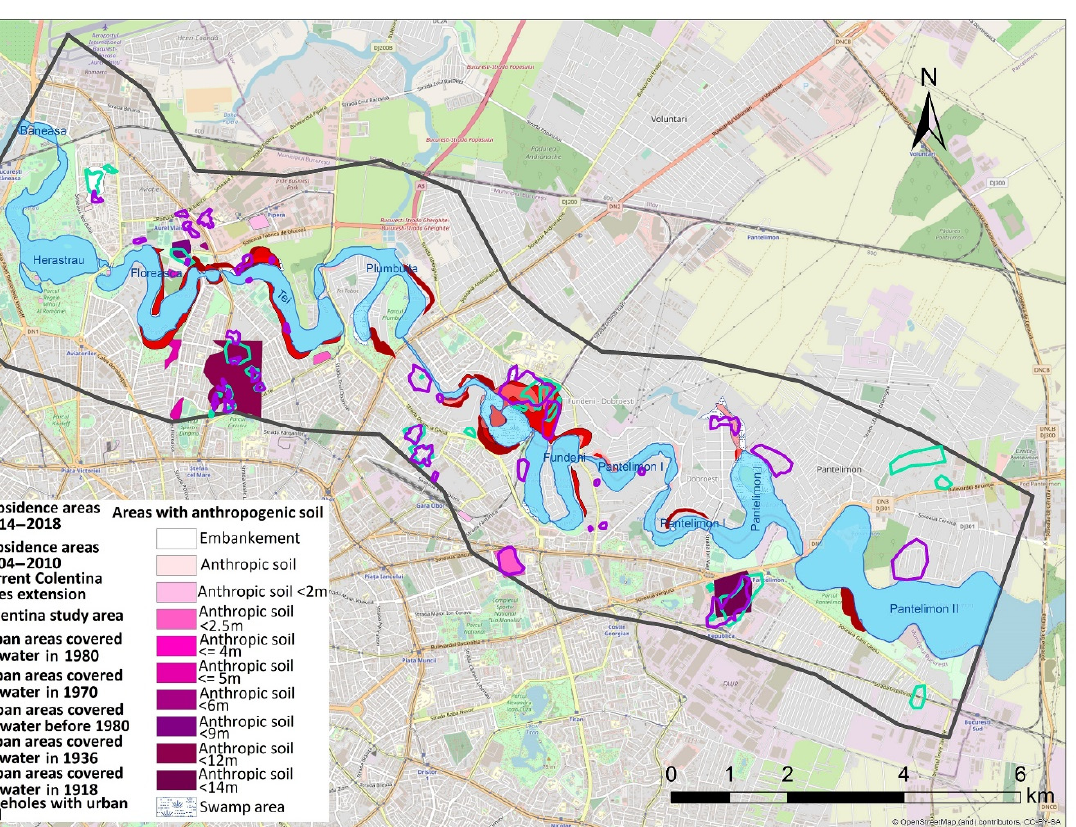
Table 4. Processed information for Promenada, Pod BV, Gara Herastrau, and Soseaua Nordului areas. Used data sources [28,38,41,64].